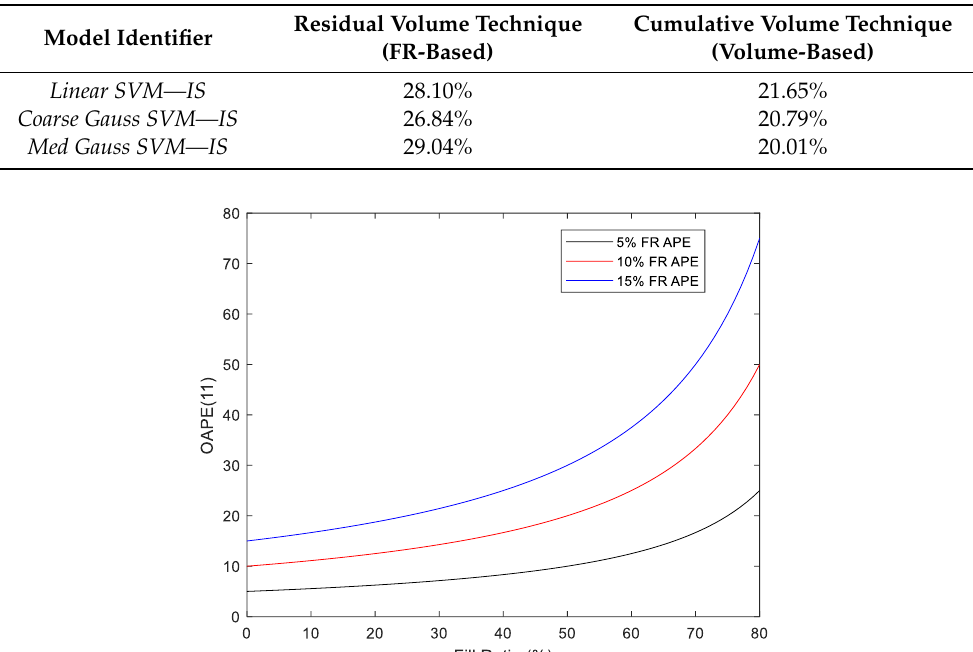
Table 7. Volume estimation accuracy enhancement using fill ratio information (baseline value with no fill ratio information: 52.77%).